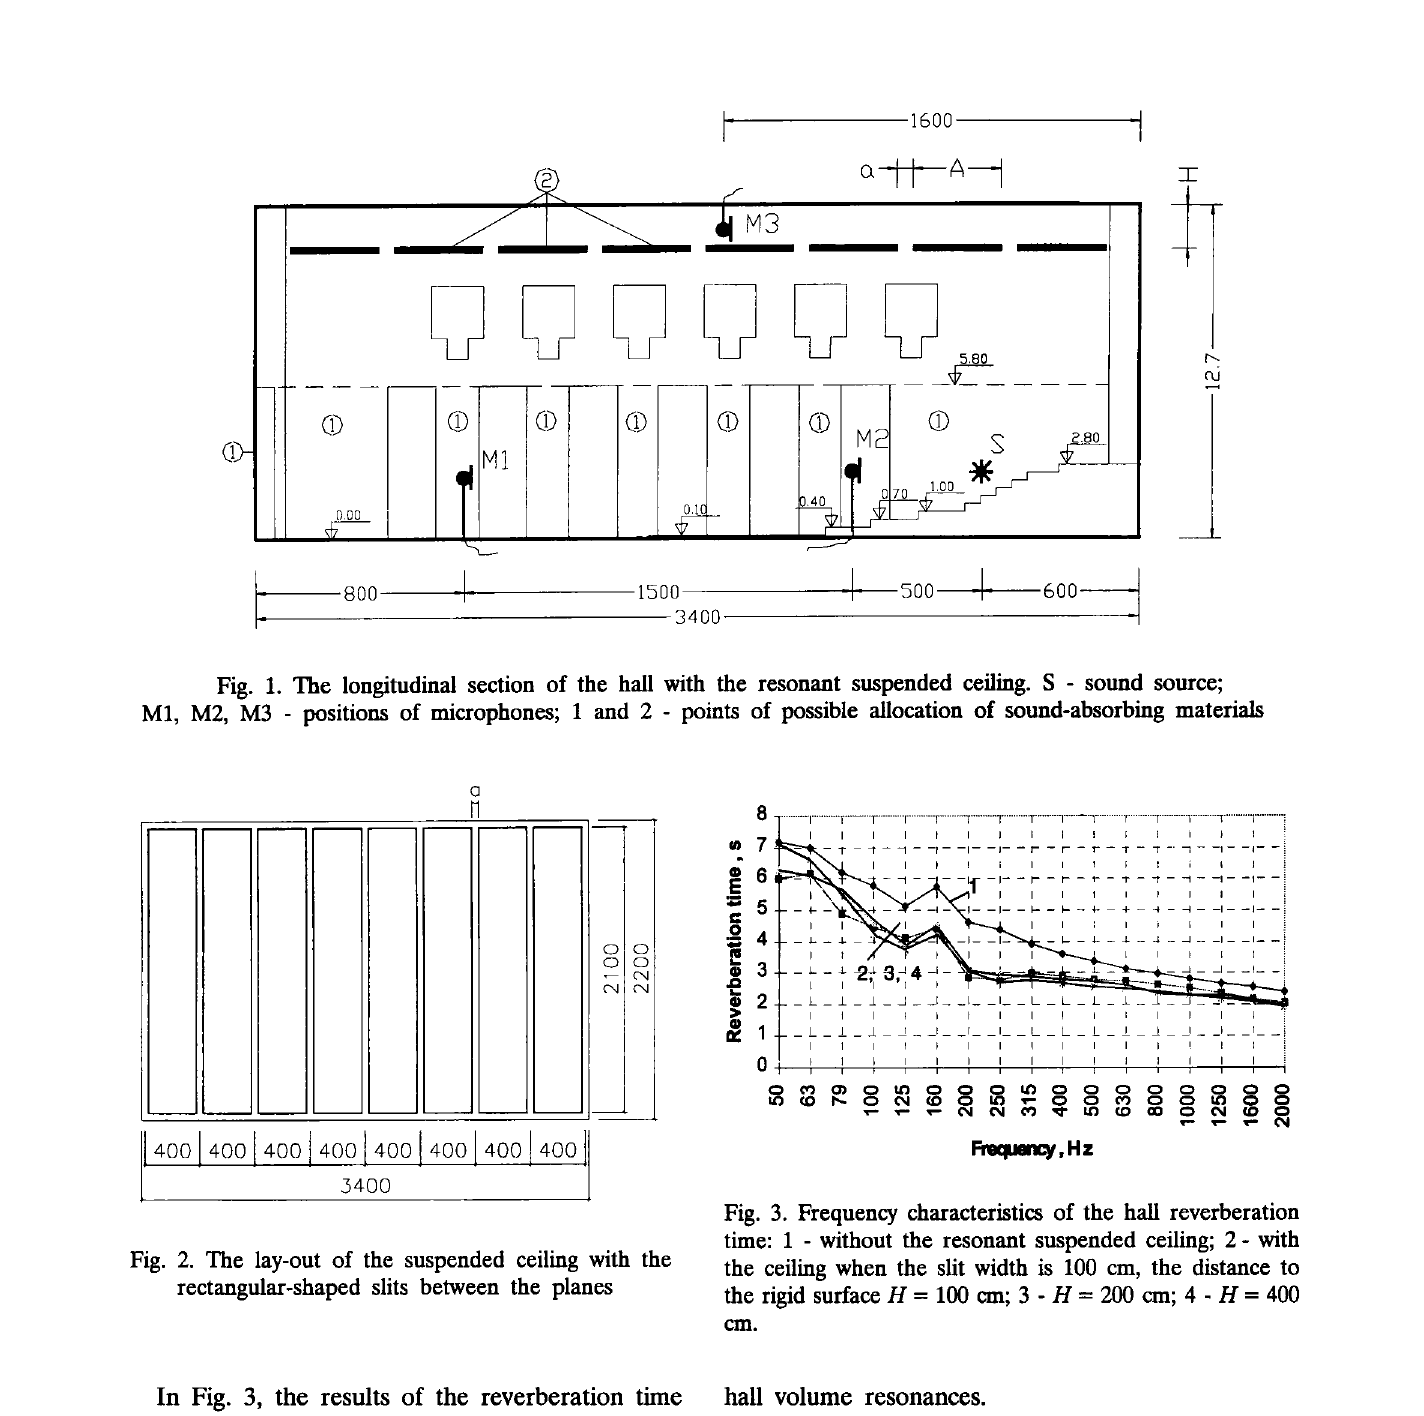
Fig. 2. The lay-out of the suspended ceiling with the rectangular-shaped slits between the planes